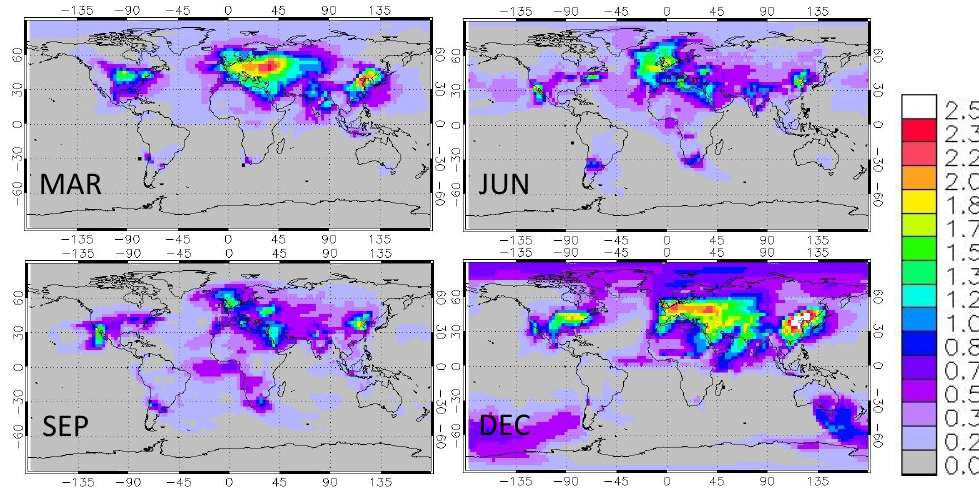
Fig. 3. Fractional change in simulated surface SOA concentrations due to two-product (2p) parameter updates (MZ4-C1) relative to the base-case.